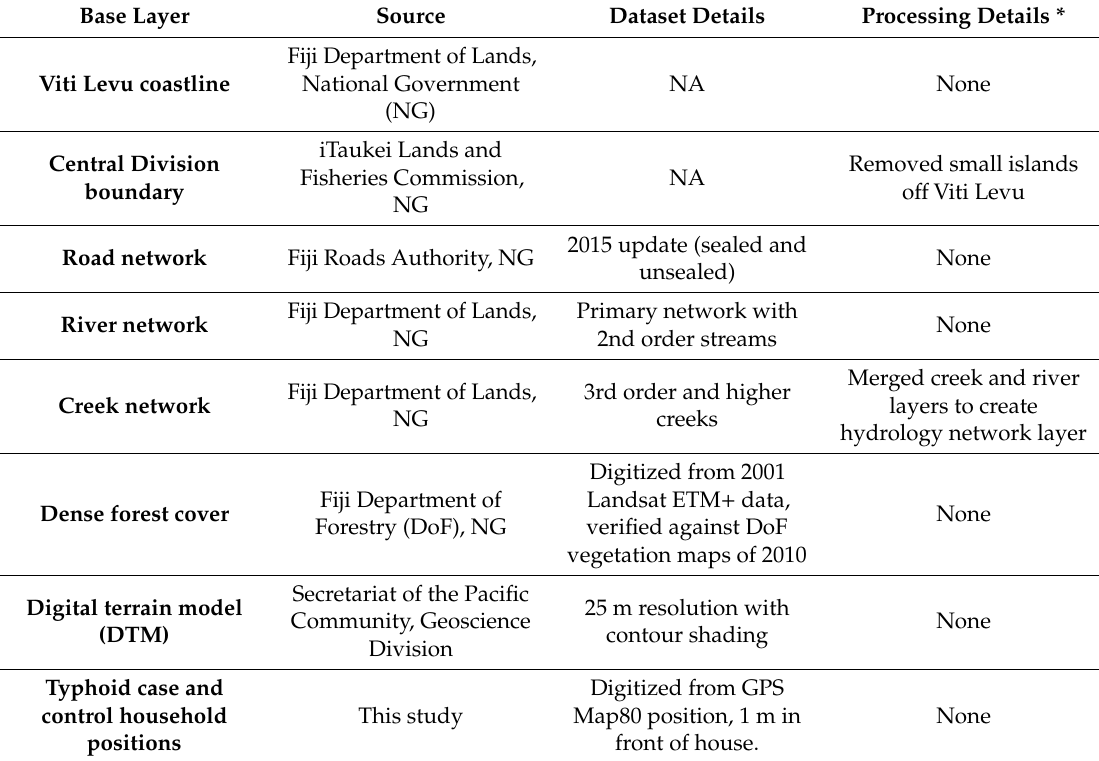
Table 1. Geospatial data layers, sources, and data processing, Fiji typhoid case-control study, 2014–2015. Base Layer Source Dataset